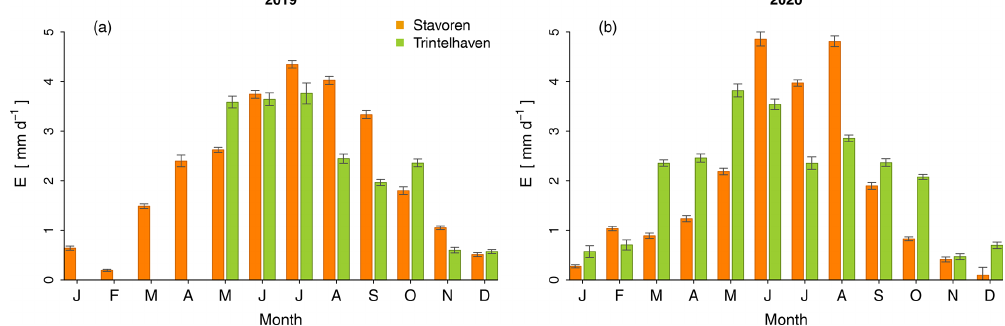
Figure 4. Yearly cycle of observed open water evaporation in Stavoren (orange) and Trintelhaven (green) based on half-hourly data for both of the respective years, 2019 and 2020. The bars indicate the monthly average evaporation, and the whiskers represent the uncertainty, which is defined as the standard deviation divided by the square root of the number of